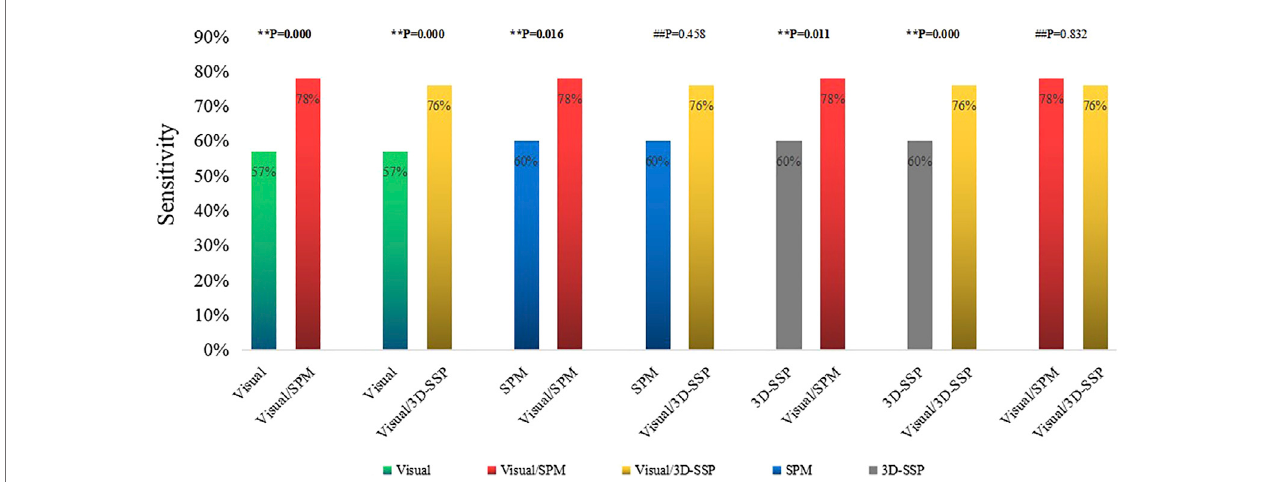
FIGURE 3 | Comparison of the sensitivities of single method, two combined methods (**P ＜ 0.05, ##P ＞ 0.05). Visual/SPM, Visual assessment combined with SPM; Visual/3D-SSP, Visual assessment combined with 3D-SSP.